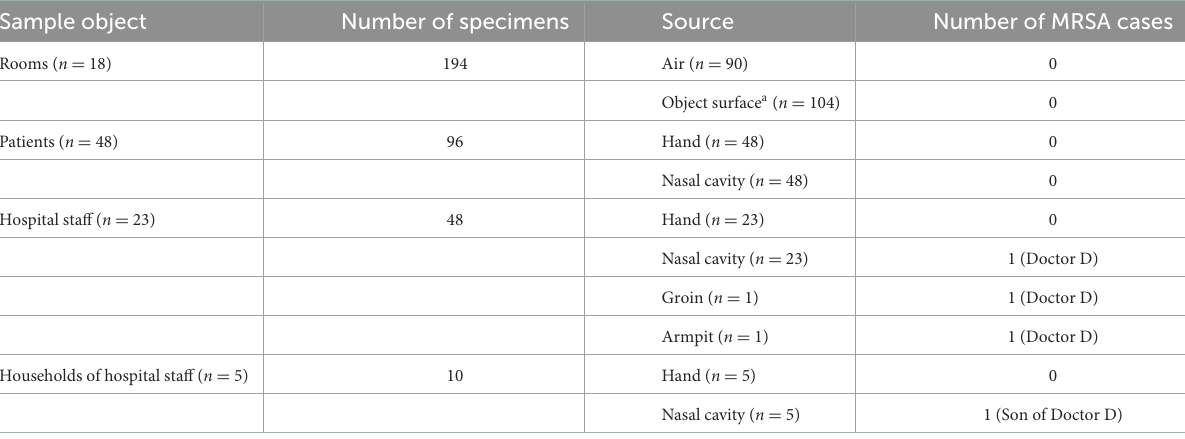
TABLE 2 MRSA screening sampling statistics.